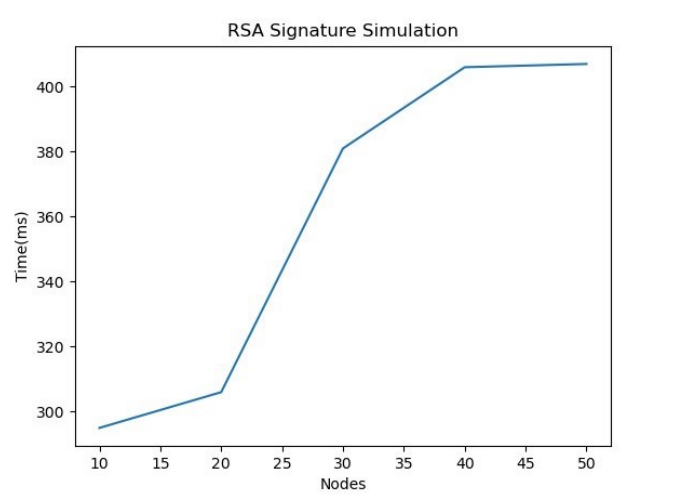
Figure 2. RSA Signature Simulation on 10 nodes to 50